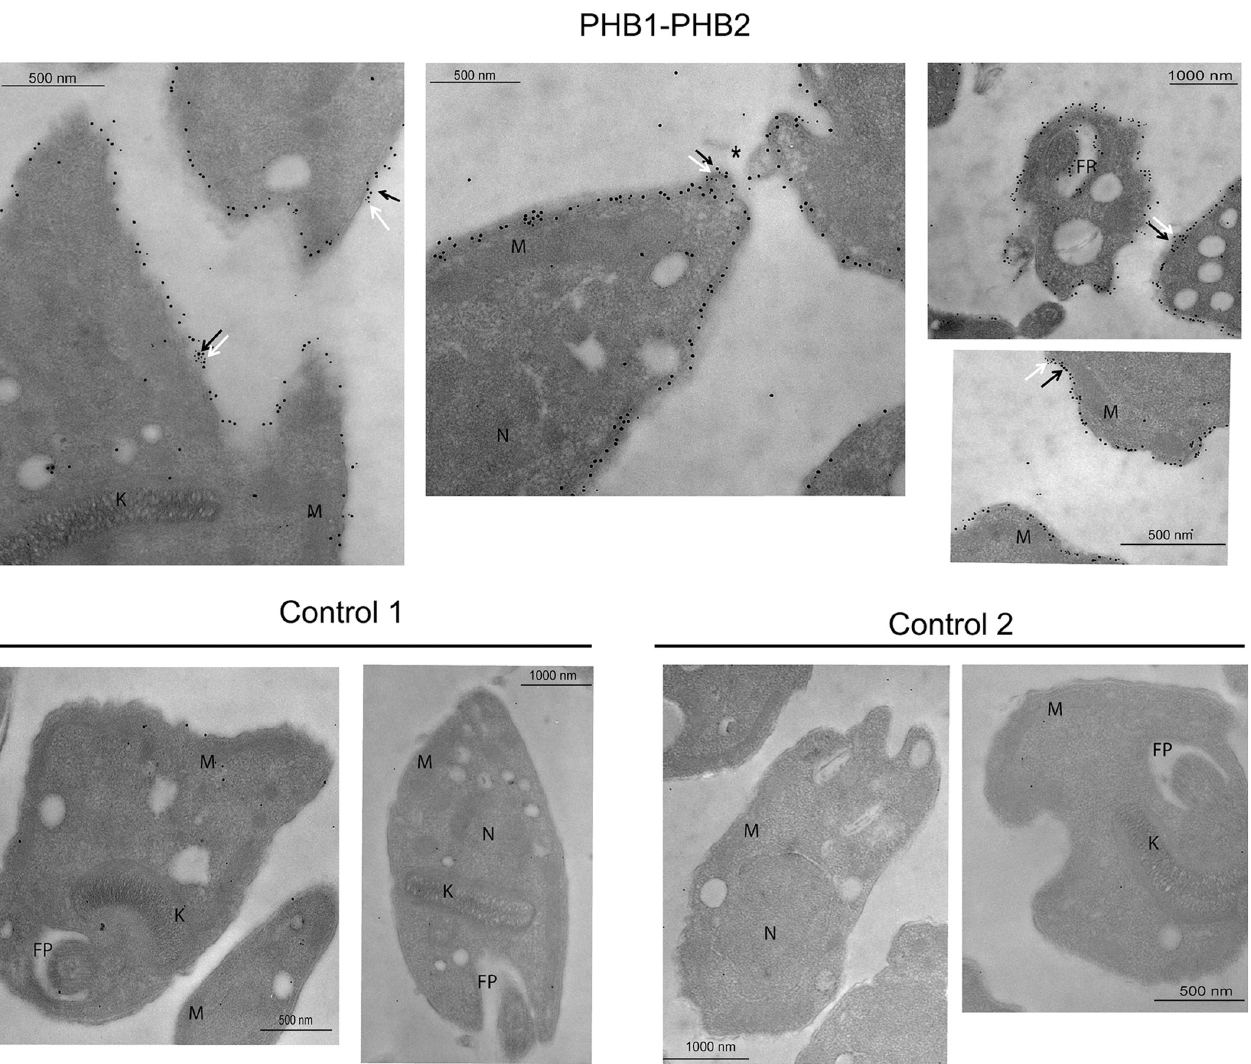
Fig 7. Localization of both proteins, PHB1 and PHB2, close to each other in the plasma membrane of trypomastigotes. Ultrathin sections were incubated with anti-PHB1 and anti-PHB2 antibodies, followed by secondary antibodies coupled to 10 nm or/and 18 nm gold particles. K: kinetoplast, M: mitochondria, N: nucleus, FP: flagellar